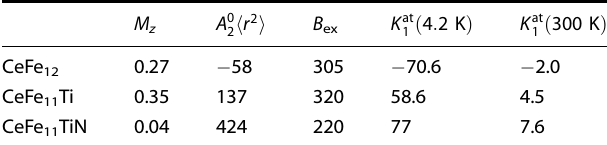
Table 1. Ce-4 f magnetic moment M z ( μ B ) obtained in DMFT(QMC) (at 300 K), as well as the lowest-rank crystal fi eld parameter A 2 exchange fi eld B ex (Tesla), and the quasi-atomic Ce single-ion anisotropy constants K at [K] (at 4.2 and 300 1